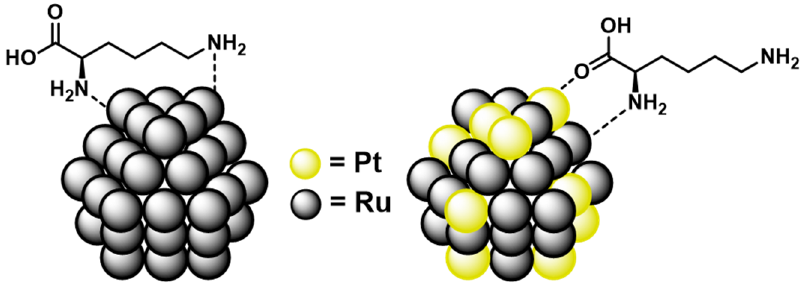
Figure 17. L ‐ lysine interaction with Ru and RuPt NPs. Extracted with permission from reference 25. Copyright 2019 The Royal Society of Chemistry.